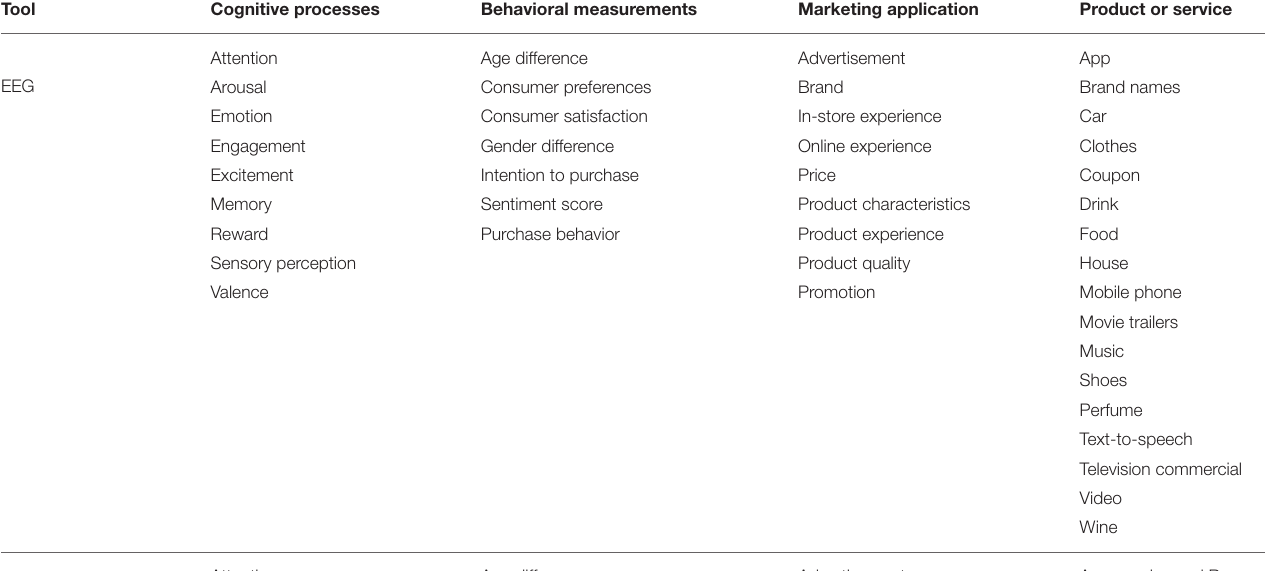
TABLE 3 | Neurophysiological tools: applications in marketing, products, and services.